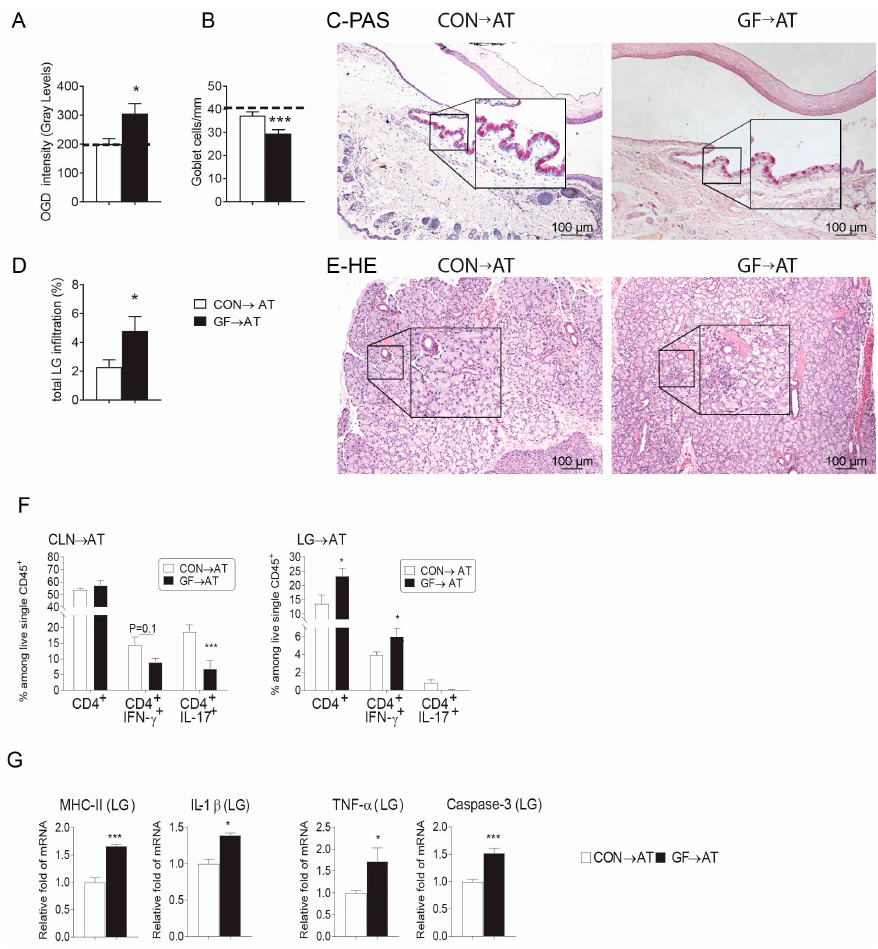
Figure 4. CD4 + T Cells from germ-free mice transfer Sjögren-like lacrimal Keratoconjunctivitis to immunodeficient RAG1KO mice. CD4 + T cells were isolated from spleens and cervical lymph nodes (CLN) from conventionally housed (CON) and germ-free (GF) mice and adoptively transferred ( → AT) into RAG1KO mice. Disease severity parameters were evaluated five weeks later. Bar graphs show means ± SEM of a representative experiment with 18–20 samples per group. ( A ) Corneal barrier function measured by Oregon-Green dextran fluorescence intensity score. Bar graphs show means ± SEM of two independent experiments with four animals per experiment (final n = eight animals, female sex). Dotted line demonstrates OGD fluorescence intensity score in naïve RAG1KO mice; ( B ) Number of PAS + conjunctival goblet cells counted in paraffin-embedded sections expressed as number per millimeter. Bar graphs show means ± SEM of two independent experiments with three animals per group, yielding a final sample of six right eyes for each group. Dotted line demonstrates goblet cell density in naïve RAG1KO mice; ( C ) Representative images of conjunctiva sections stained with PAS (purple cells) used to generate the bar graph in ( B ). Black rectangular insets are a high magnification of the small demarcated area; ( D ) Total lacrimal gland infiltration measured in H&E stained sections as shown in ( F ) ( n = six right lacrimal glands); ( E ) Representative images of haematoxylin and eosin (H&E)-stained sections. Black rectangular insets are a high magnification of small demarcated area; ( F ) Percentage of total CD4 + T, Th1 (CD4 + IFN- γ + ), Th2 (CD4 + IL-13 + ), Th17 (CD4 + IL-17 + ) cells in freshly isolated cervical lymph nodes (CLN) and lacrimal glands (LG) by flow cytometry five weeks post-adoptive transfer. Each experiment group consisted of three-to-four samples; showing mean ± SEM of two independent experiments. CLN of the same animal were pooled; right and left extraorbital LGs of the same animal were pooled. Bar graphs show means ± SEM of two independent experiments with four animals per experiment (final n = eight animals, female sex); ( G ) Relative fold expression changes of MHC II, IL - 1 β , TNF - α and Caspase 3 in LG. Bar graphs show means ± SD of six samples per group, biological replicates from two independent experiments were averaged. * p < 0.05; *** p < 0.001Mann-Whitney U GF vs. CON comparison test.